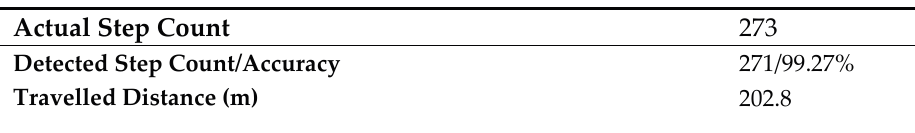
Table 2. Tranking performance of the second short-termexperiment.